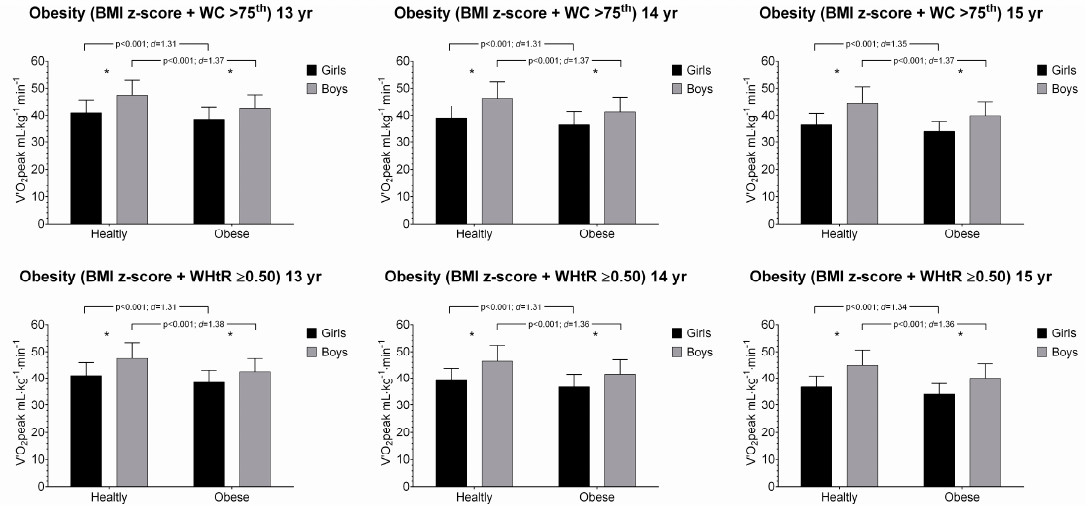
Figure 2. Relative peak oxygen uptake ( 𝑉(cid:4662) O 2 peak) and combined anthropometric parameters (BMI z-score + WC and BMI z-score + WHtR) by age and sex group. Values are mean and standard deviation. * p < 0.001 for sex.